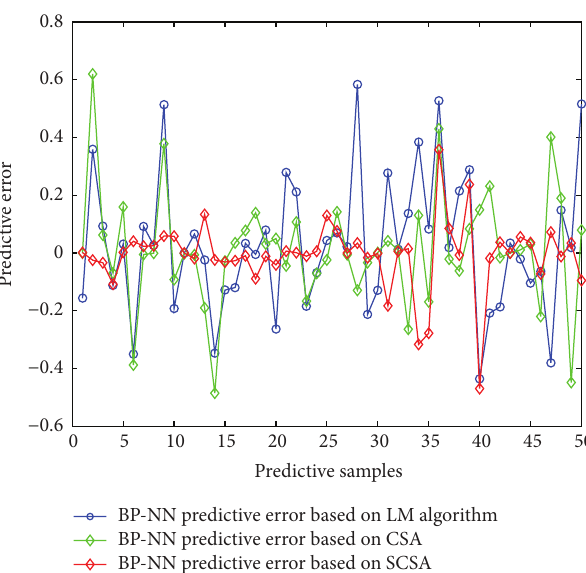
Figure 13: Predictive errors of soft-sensor